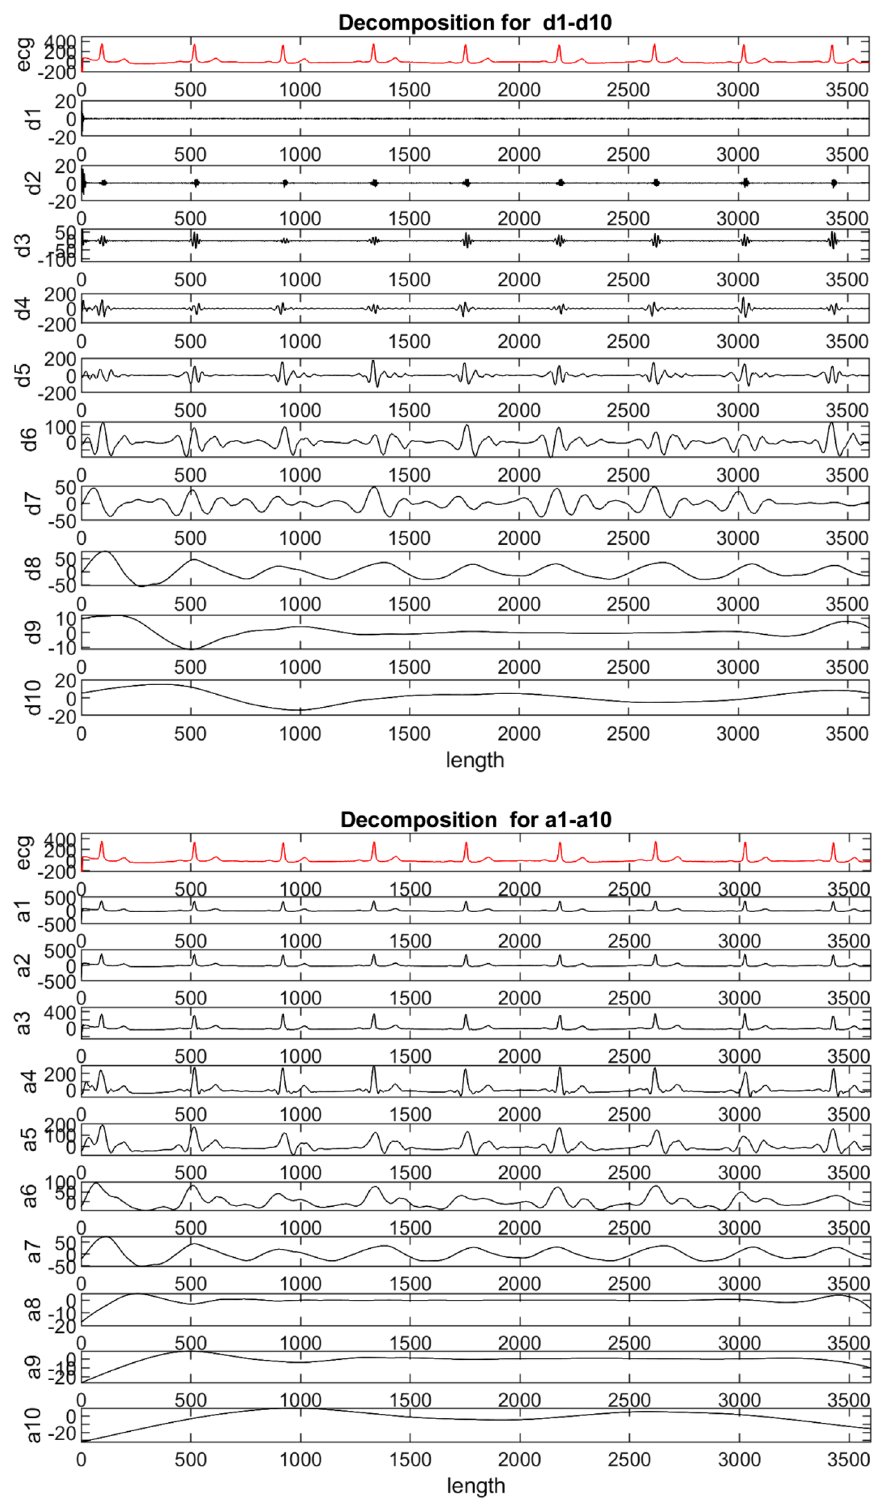
Figure 11. Decomposition for d1–d10 and a1–a10 of ECG Signal using db6 level 10